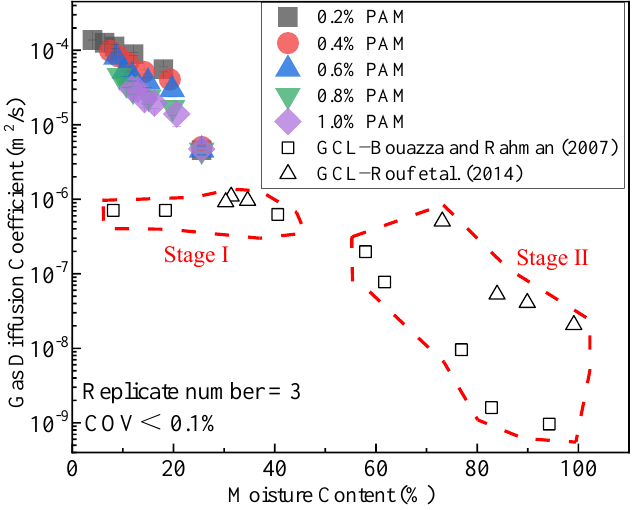
Figure 8. Relationship between the gas diffusion coefficient and moisture content of the compacted clay after PAM modification [11,57].